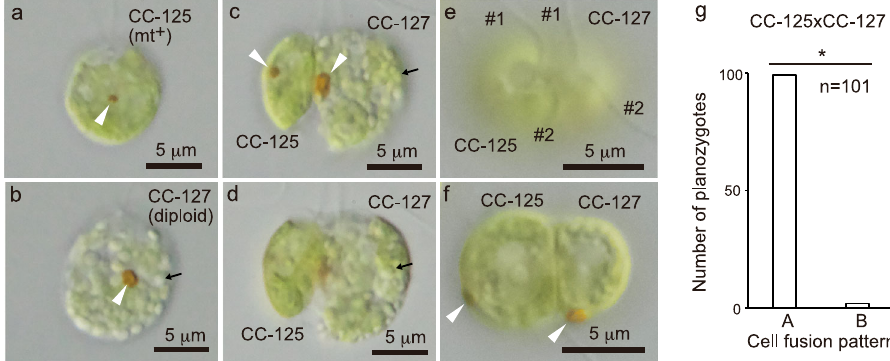
Fig. 5 Spatial positioning of the mating structure in heterozygous diploid strain CC-127 gamete. a , b Differential interference contrast images of the wild-type CC-125 (mt + ) ( a ) and CC-127 (mt – ) gametes ( b ). In contrast to CC-125, the CC-127 gamete was fi lled with starch grains (arrow). c , d Differential interference contrast side-view images of the planozygote 25 min after mixing wild-type CC-125 (mt + ) and CC-127 (mt – ) gametes. Two eyespots aligned on the same side of the cell. e , f Differential interference contrast top-view images of the planozygote 25 min after mixing wild-type CC-125 (mt + ) and CC- 127 (mt – ) gametes. Gamete – gamete fusion occurred on the side of the beat plane opposite the eyespot in the wild-type (mt + ) gamete and on the same side in the diploid gamete. Images were focused on the upper surface ( c , e ), lower surface ( d ) and equator ( f ) of the cell body, respectively. Arrowheads indicate the eyespots. g Number of planozygotes with two eyespots on the same side (A) or opposite side (B) of the cell at 25 min after mixing the gametes. Similar results were obtained from three independent experiments ( n = 101, 102 and 103), and a representative result is shown. *Signi fi cant difference between (A) and (B) by the binomial test ( p < 0.01, parameter θ = 0.5). #1 : no. 1 fl agellum, #2 : no. 2 fl